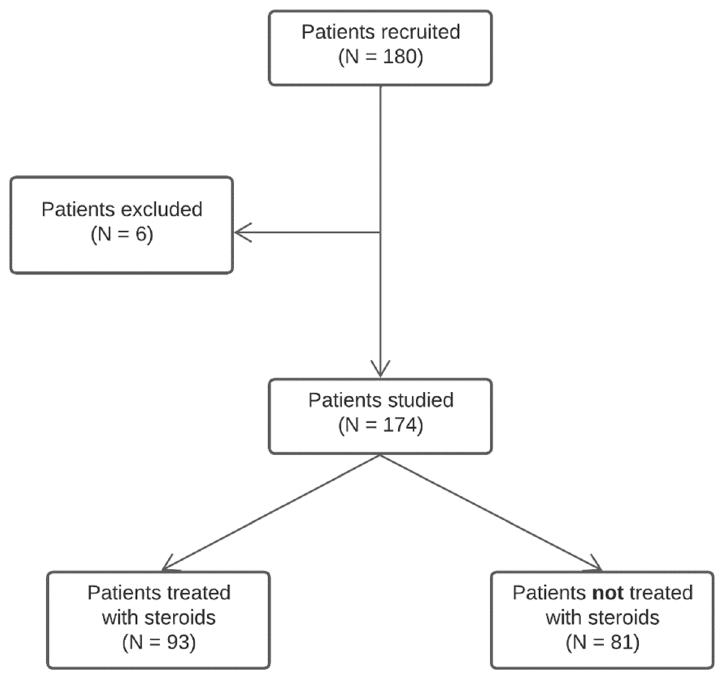
Figure 1. The history of group recruitment.